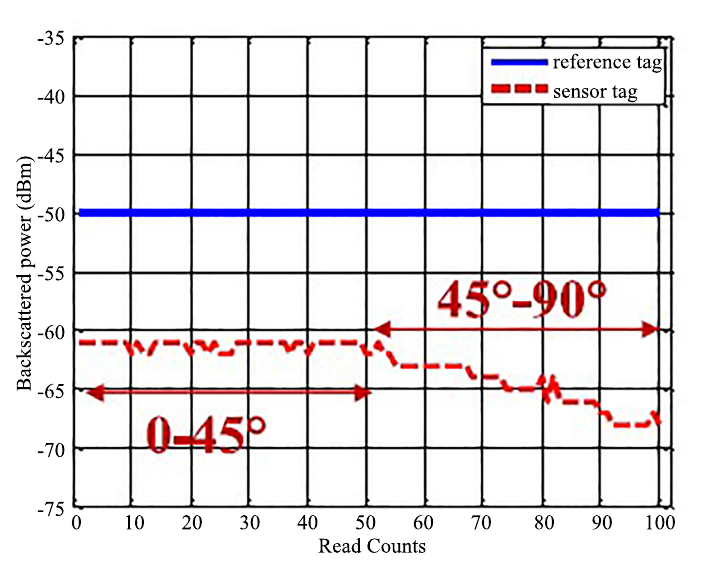
Figure 21. The results of a strain sensor showing varying RCS at different strain levels